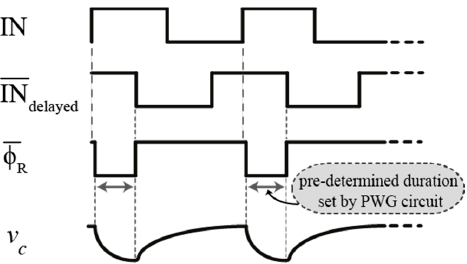
Figure 6. Timing diagram showing how the reset signal activation is synchronized with the input reference pulse.